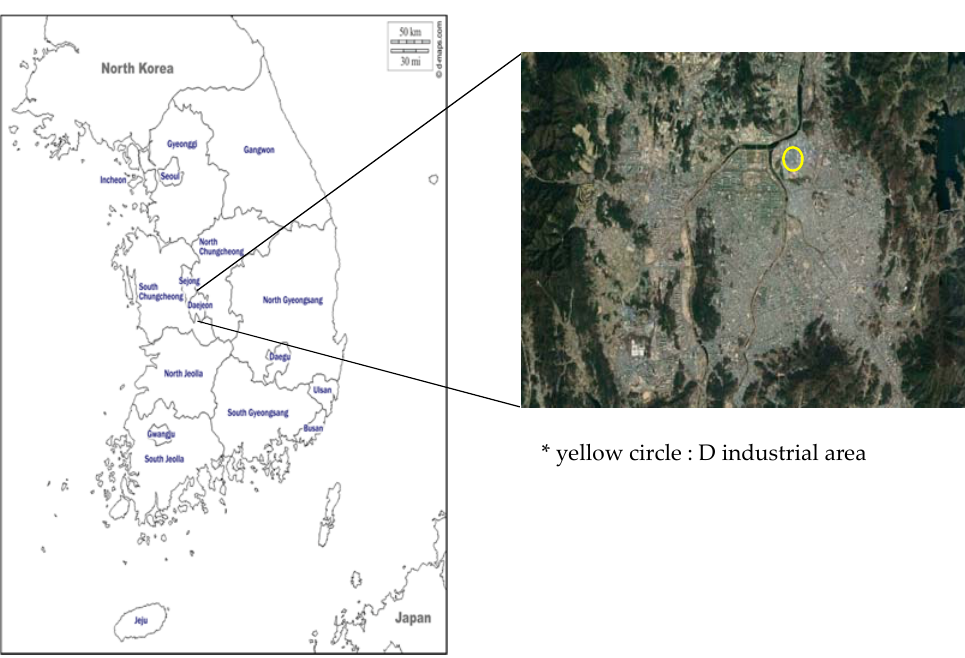
Figure 1. Sampling site location in D industrial area, Daejeon, Republic of Korea. Table 1. Details of wood core samples collected and sites of collection Site No.